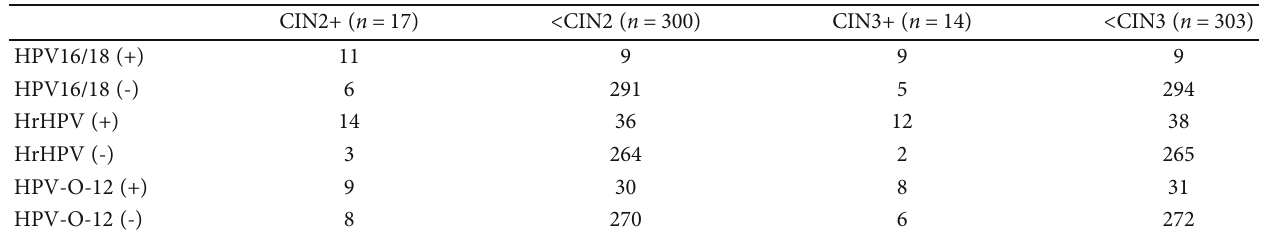
Table 3: HPV distribution with histological diagnoses in women with ASC-US ( n = 317